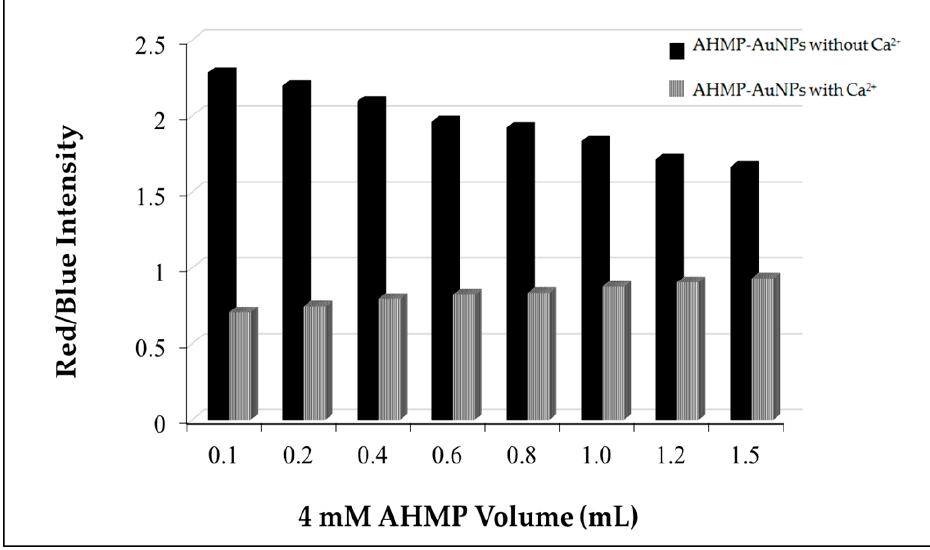
Figure 3. The red/blue intensity of the AHMP-AuNPs at different AHMP volumes at 0.1, 0.2, 0.4, 0.6, 0.8, 1.0, 1.2, and 1.5 mL without (solid bar) and with (thin bar) 100 ppm Ca 2 + , AHMP-AuNP: sample 0.8, 1.0, 1.2, and 1.5 mL without (solid bar) and with (thin bar) 100 ppm Ca 2+ , AHMP-AuNP: sample volume ratio at volume ratio at 1:1.